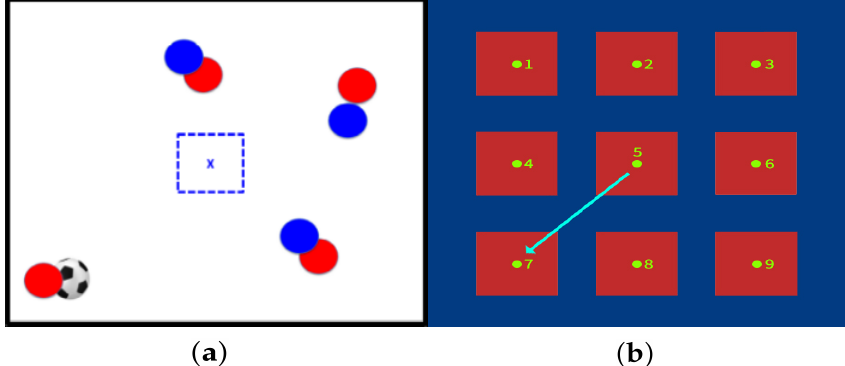
Figure 3. Example of soccer tactical situation and the expected response. ( a ) Defensive tactical situation marks red player with ball possession. ( b ) Response is running to target 7 on the platform (assuming marking